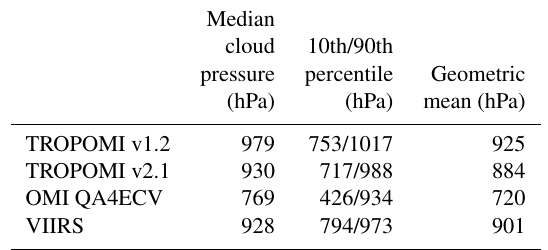
Table 3. Evaluation of TROPOMI v2.1 cloud pressures against ref- erence data for the Bay of